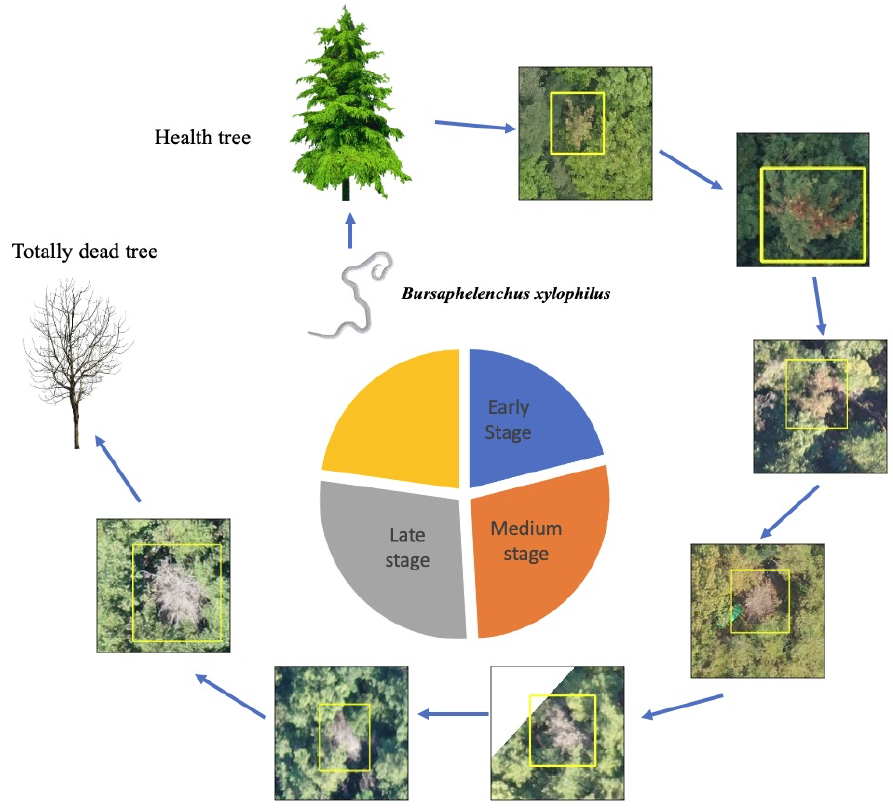
Figure 5. Symptoms of each stage of PWD